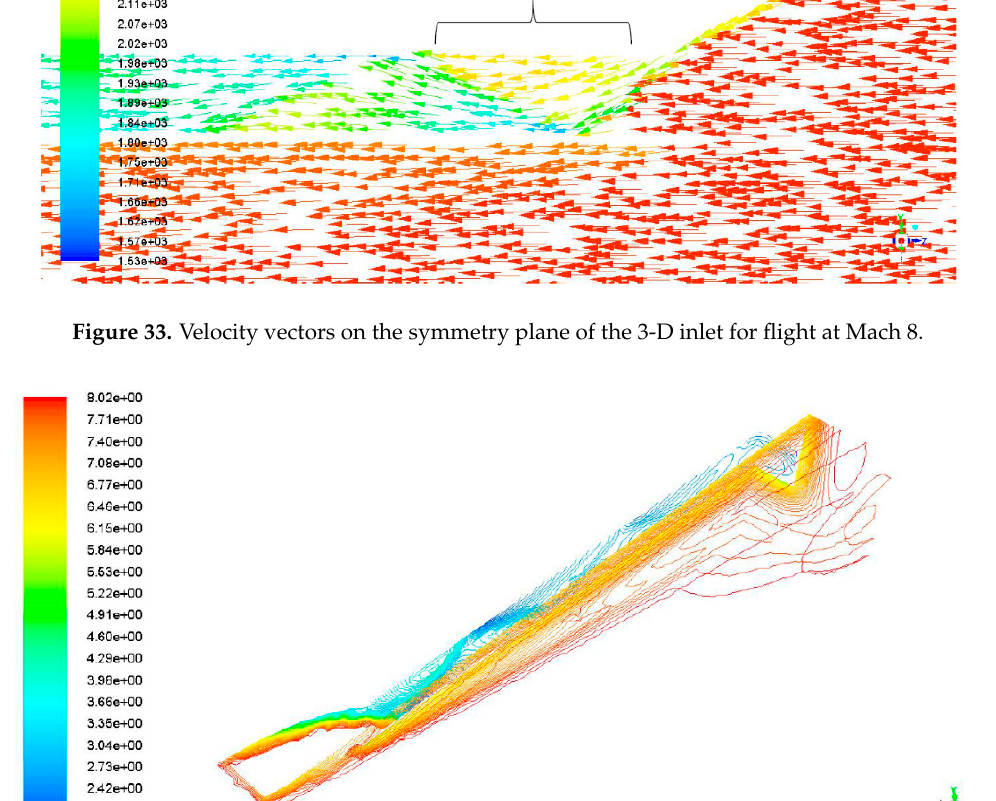
Figure 33. Velocity vectors on the symmetry plane of the 3-D inlet for flight at Mach 8.